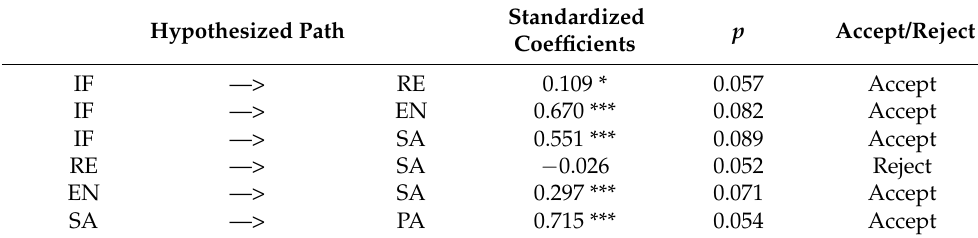
Figure 2. Final path diagram of structural equation modeling. Note: IF: Cognition of the development level of facilities for forest tourism, RE: Perceived value of landscape resources, EN: Perceived value of ecological environment, SA: Tourists’ satisfaction, PA: Tourists' willingness to visit the forest park. Table 7. Standardized regression weights of the structural equation